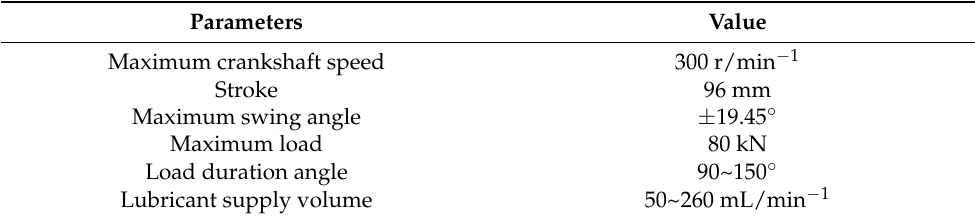
Figure 2. Structure of the test module. Table 1. Structural parameters of the test rig.